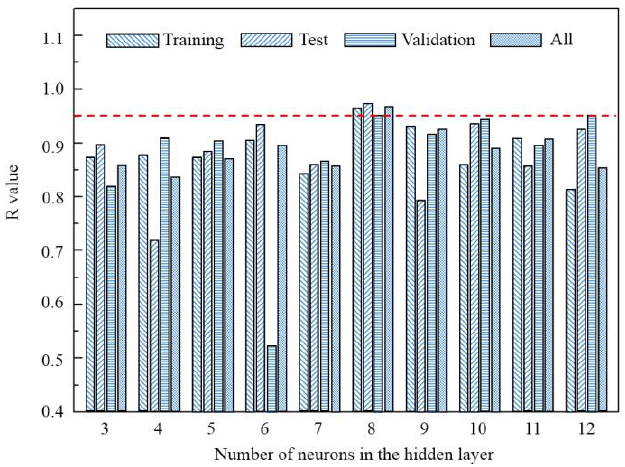
Figure 4. The correlation coefficient (R) values obtained from the trained BP model for HV from different numbers of hidden neurons.